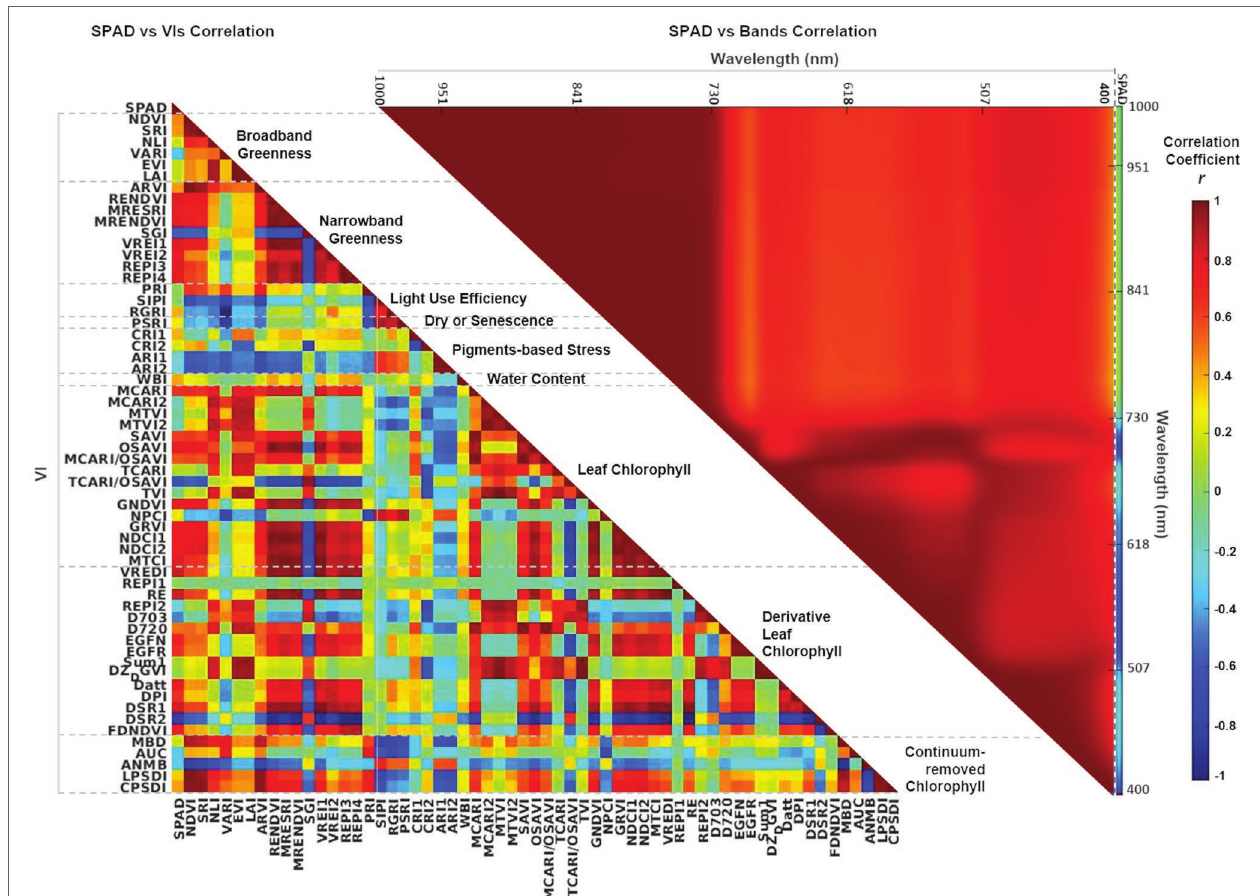
FIGURE 5 | Correlation matrices showing Pearson’s r coefficient between SPAD and individual VIs (left-hand side), and between SPAD and individual spectral bands (right-hand side). The first column in the SPAD versus VIs matrix (left) and the last column in the SPAD versus Bands matrix (right) show the coefficients for the dependent variable SPAD. The color scale represents correlation coefficients between 1 and − 1. VIs are grouped and organized according to Supplementary Table 1